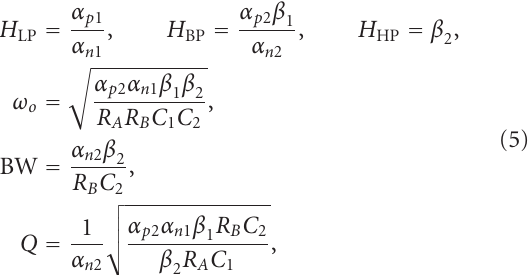
Figure 5: Frequency characteristics for LP, BP, and HP responses of the proposed circuit of Figure